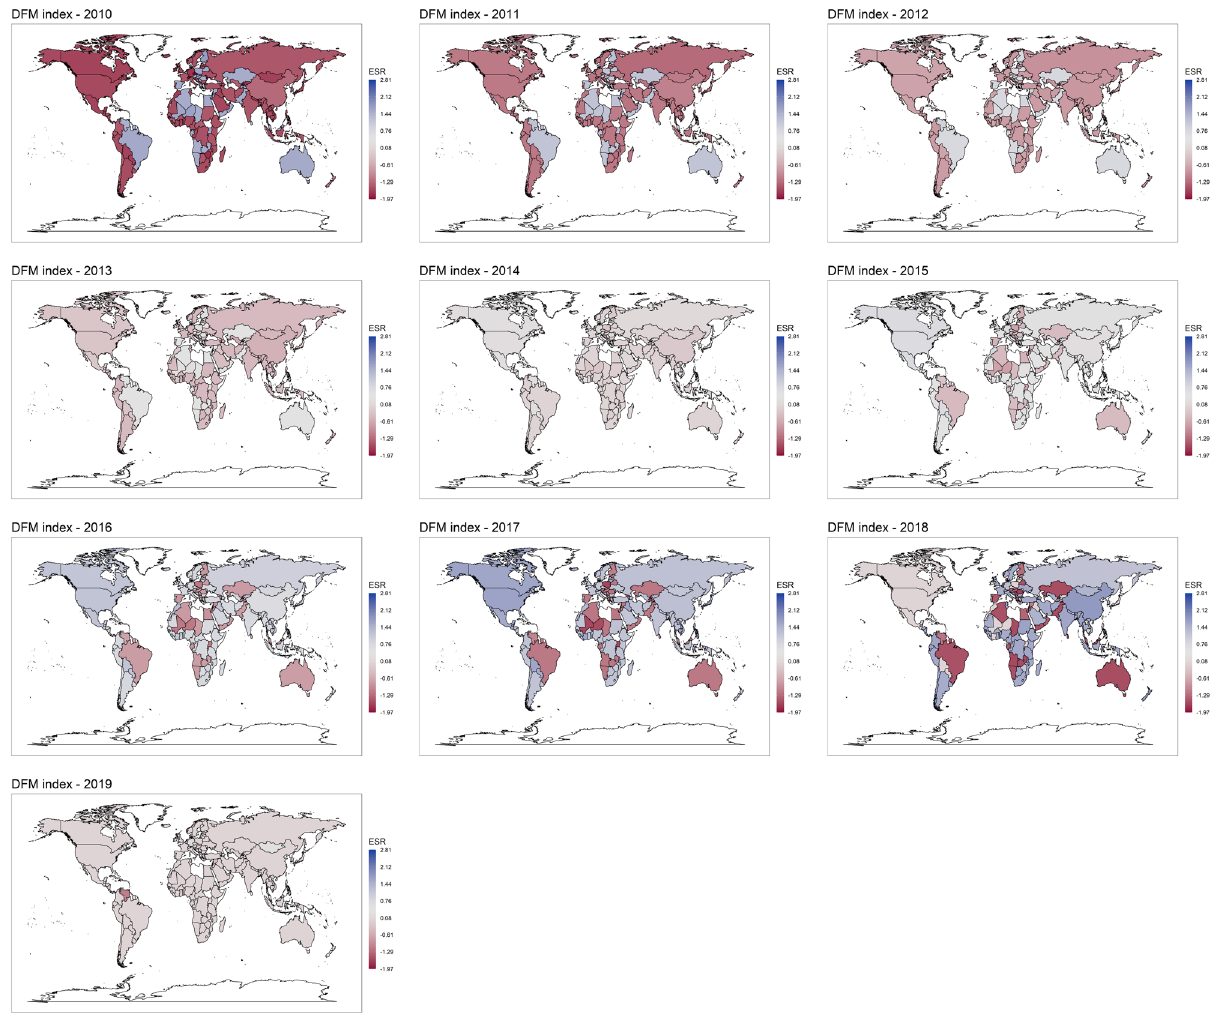
Figure 1. DFM index evolution over years. Shades of red color refer to riskier countries, while shades of blue to safer ones. Figure is generated with R software 56